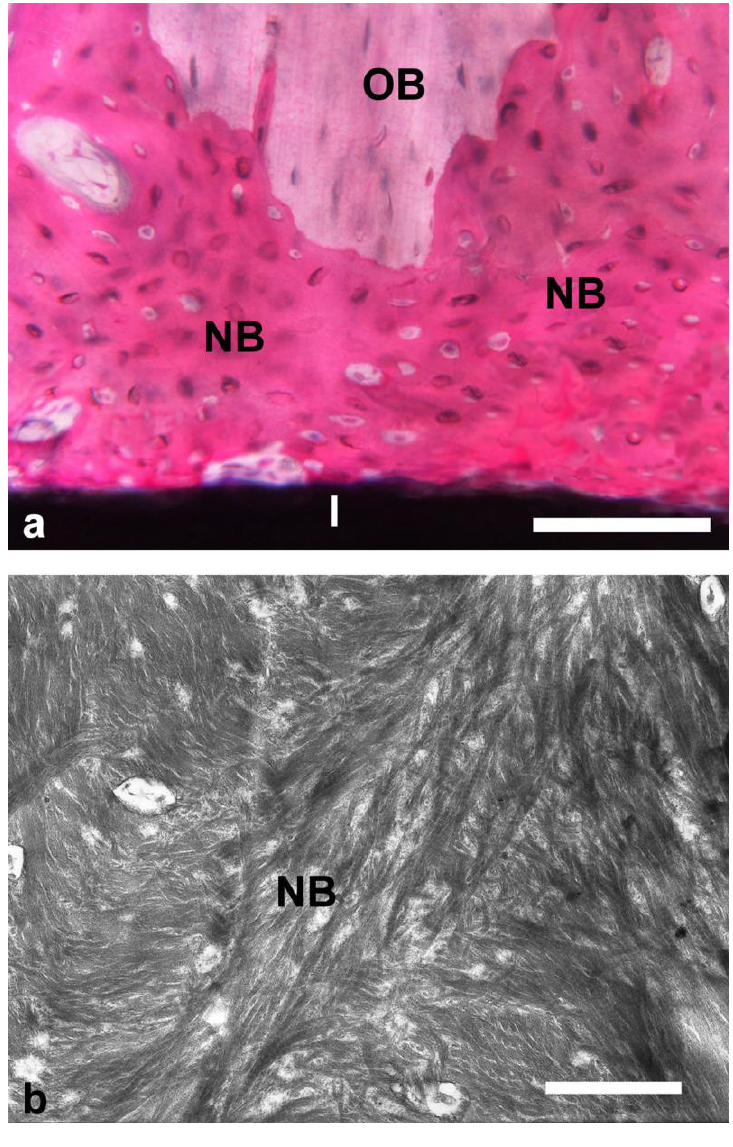
FIGURE 4. LM-TEM correlative analysis of the osteointegration process 12 weeks after implant insertion. (a) Section of a bone- implant sample observed by LM. Note the extensive areas of rearranged bone (NB) in contact with host bone (OB). I = implant. (LM, bar = 100 μm). (b) Detail of bone from the same section area shown in Fig. 4a after deacrylation of the section, implant removal, and bone processing for TEM. The figure displays a rearranged bone tissue area (NB) with differently oriented collagen fibrils. Osteocyte canaliculi with transversally cut cell extensions can also be detected. (TEM, bar = 2.5